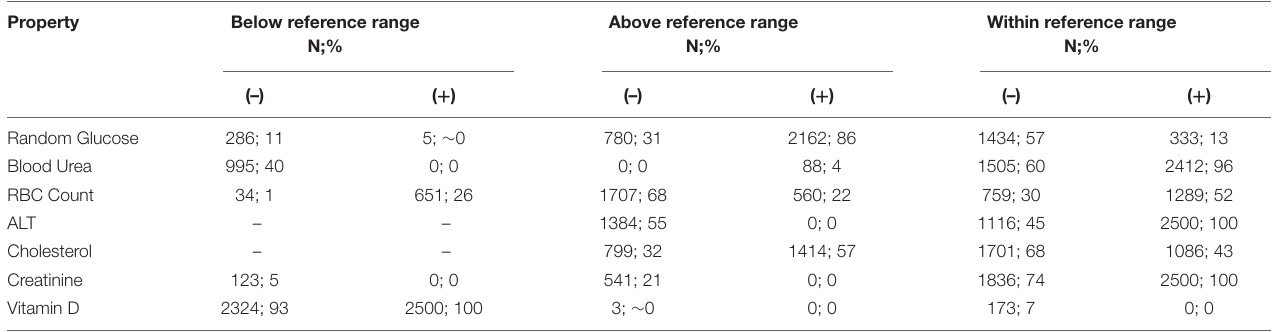
TABLE 2 | Patients’ outcomes in SARS-CoV-2 (–) (n = 2,500) and SARS-CoV-2 ( + ) group ( n = 2,500).